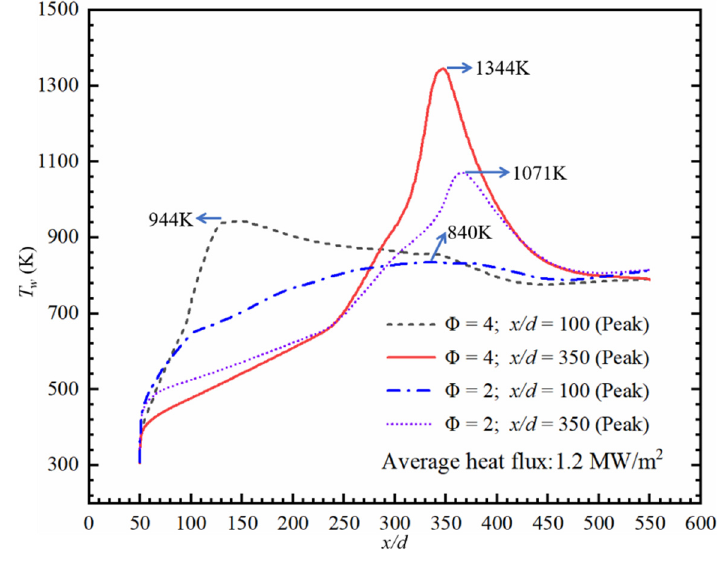
Figure 19. Wall temperature distributions under different nonuniform heat flux boundaries.